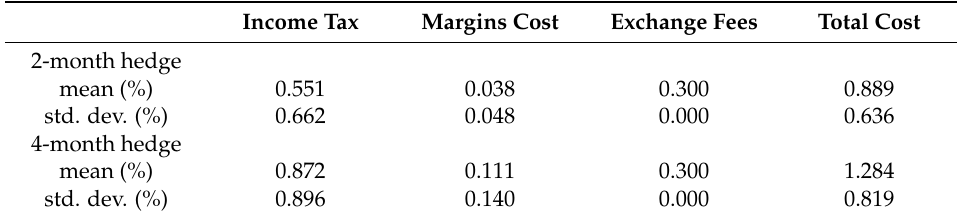
Table 2. Mean and standard deviation of transaction costs in futures trading based on simulated price trajectories with annual price volatility of 20% (a)